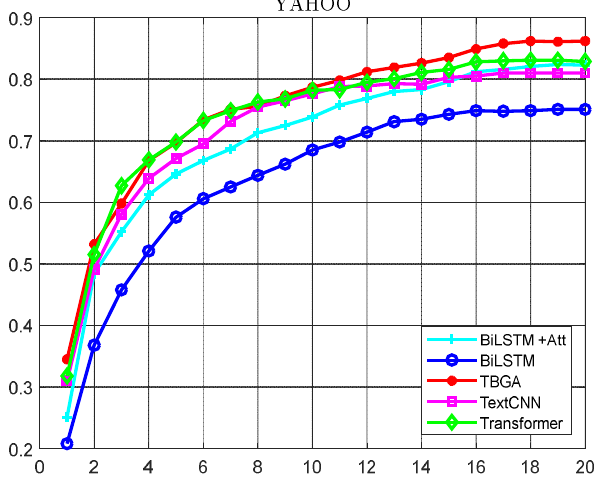
Figure 8. Comparison of accuracy rates on the YAHOO verification set.